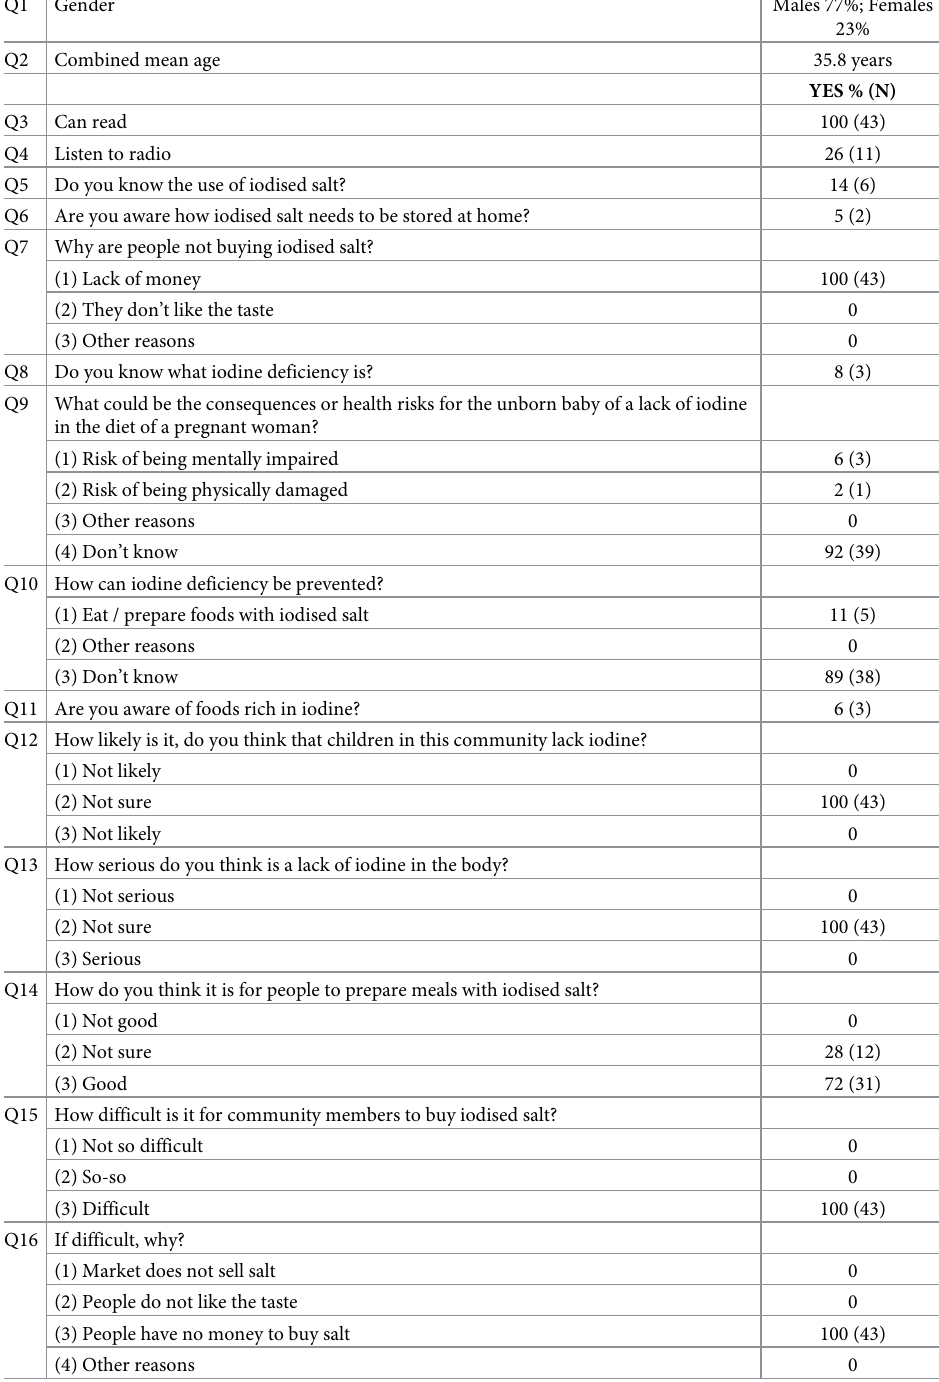
Table 4. Knowledge, attitude and practices of stakeholders (health, education staff, community leaders) (n =